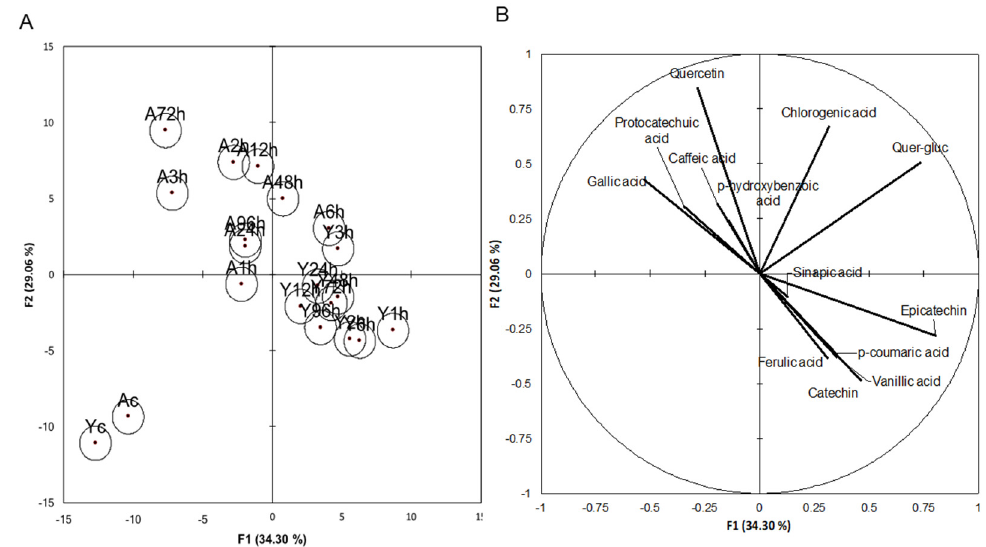
Figure 3. ( A ) Canonical Variance Analysis of young (Y) and aged (A) beers. “XXh” = hours, “c” = control ( n = 3). ( B ) Variable plot of measured polyphenolics.